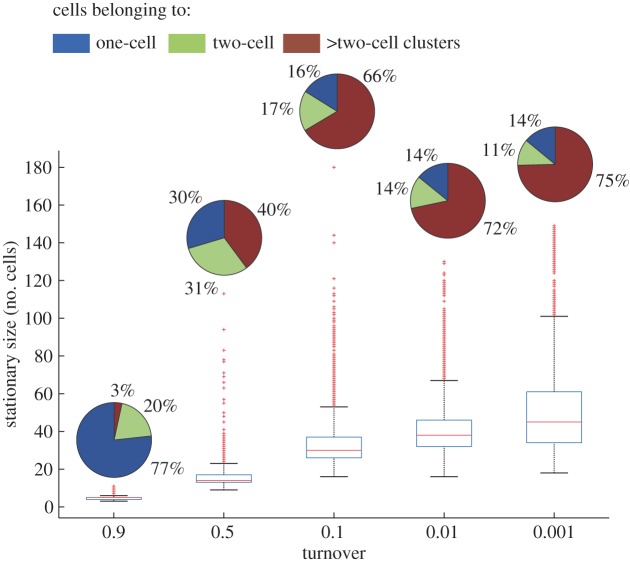
Stationary size in two-dimensional growth. The box plots show the size of the largest cluster per turnover during 100 iterations after stationary size is reached for 100 independent simulation experiments. The central bar represents the median, the edges of the box show the 25th and 75th percentiles, the whiskers cover the extreme data points not yet considered as outliers and the outliers are plotted individually as red crosses. Pie charts illustrate the relative percentage of cells, within a population of 5000 cells at carrying capacity, belonging to one-cell, two-cell or to larger clusters for a given number of iterations, once the stationary size has been reached.